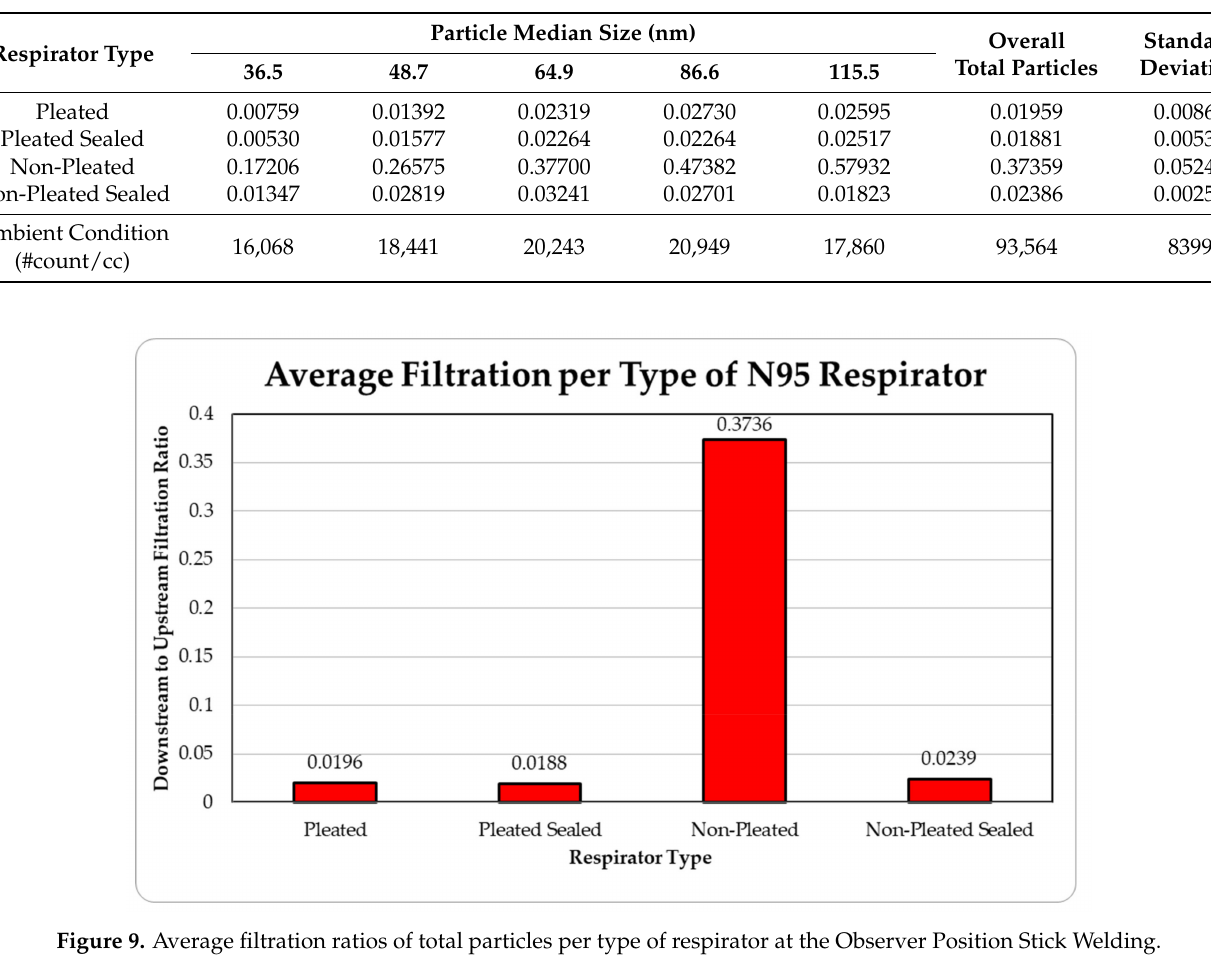
Table 3. Results of average downstream to upstream filtration ratios per type, particle size, and per respirator type at the Observer Position Stick Welding.